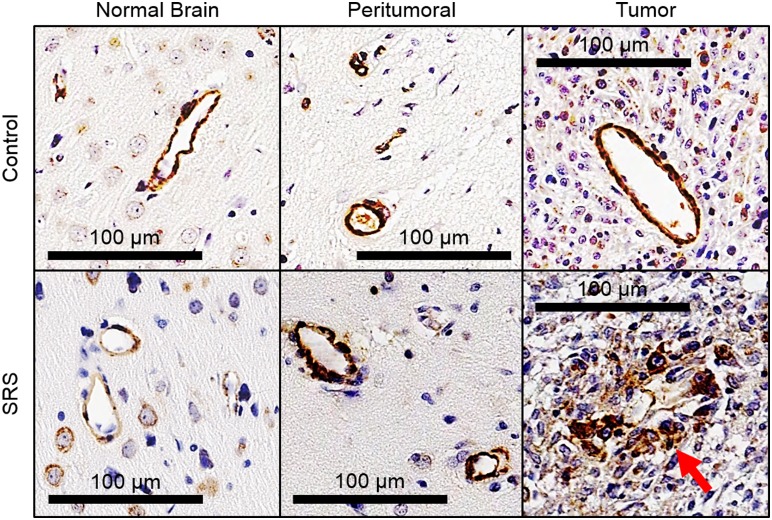
α-smooth muscle actin (α-SMA) positive vessels in the normal brain, peritumoral region, and tumor of a control and a treated animal after stereotactic radiosurgery (SRS).Intact α-SMA positive vessels were observed in control animals, but fragmented coverage of vessels by α-SMA is mostly seen in treated animals (red arrow).